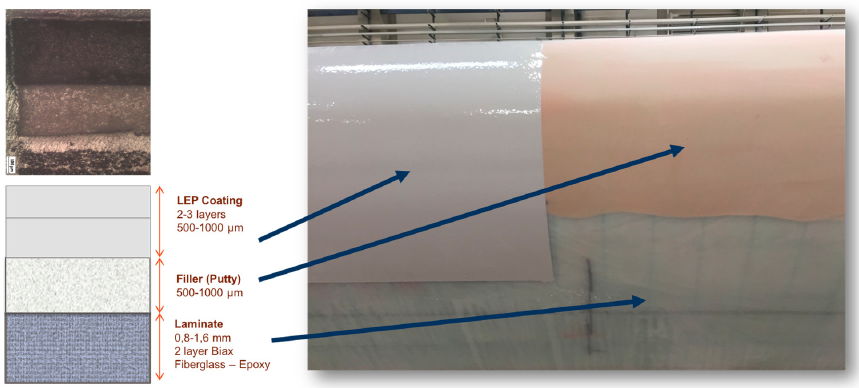
Figure 6. A particular leading edge protection system configuration on the blade surface.